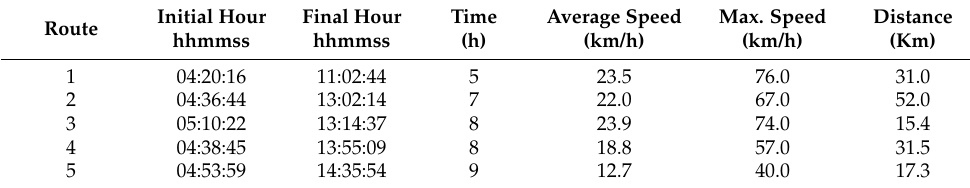
Table 4. Summary of route